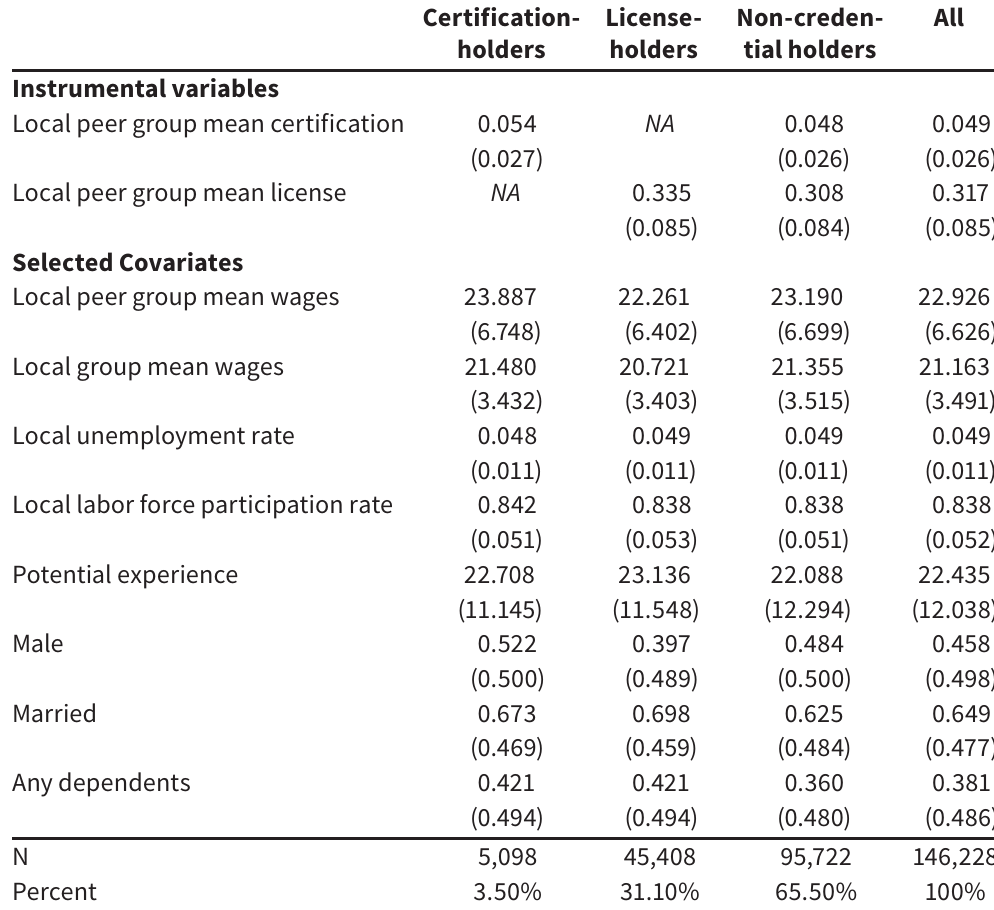
Sample Characteristics, Bachelor’s Degree or More